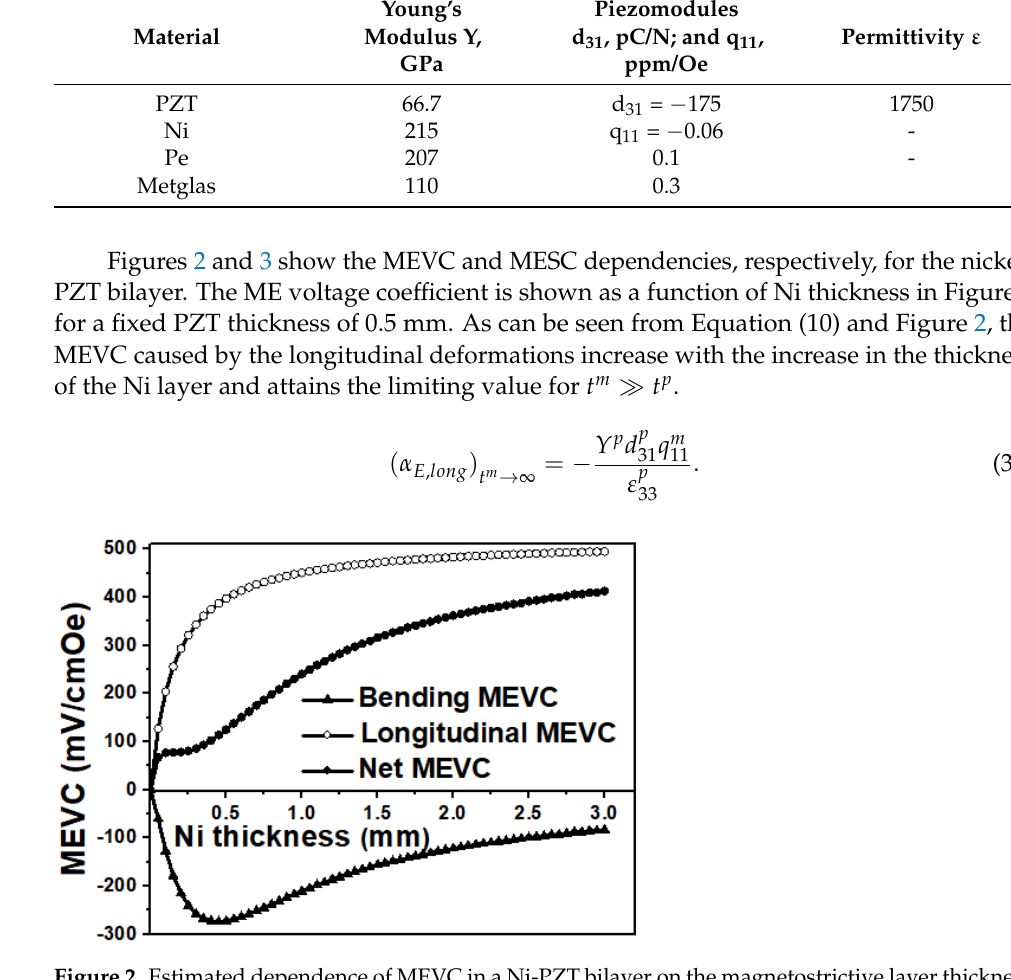
Figure 2. Estimated dependence of MEVC in a Ni-PZT bilayer on the magnetostrictive layer thickness. The piezoelectric layer thickness t p = 0.5 mm.